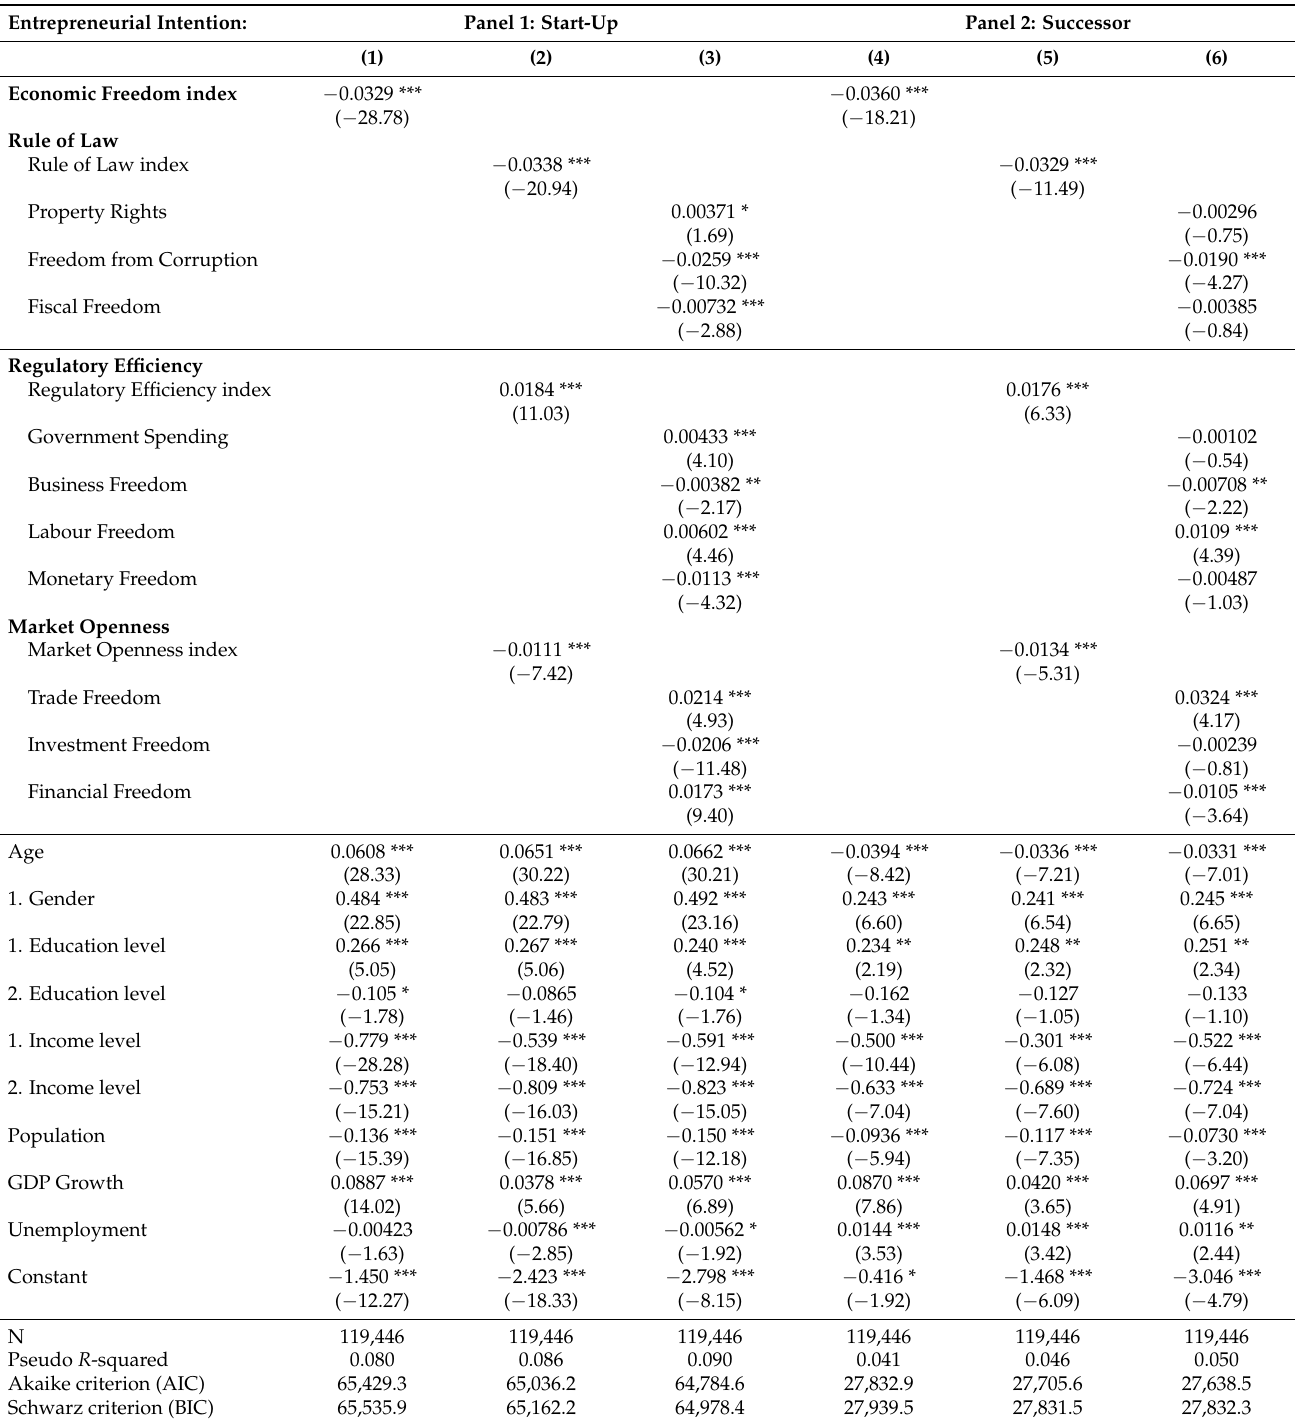
Table 6. Entrepreneurial intention and economic freedom